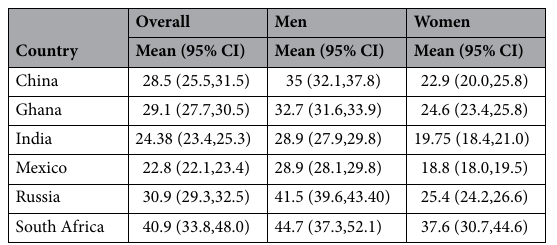
Table 1. Cross-national differences in mean age-adjusted handgrip strength in kg among older adults aged 50+ stratified by sex, WHO-SAGE Wave 1 (2007/10).